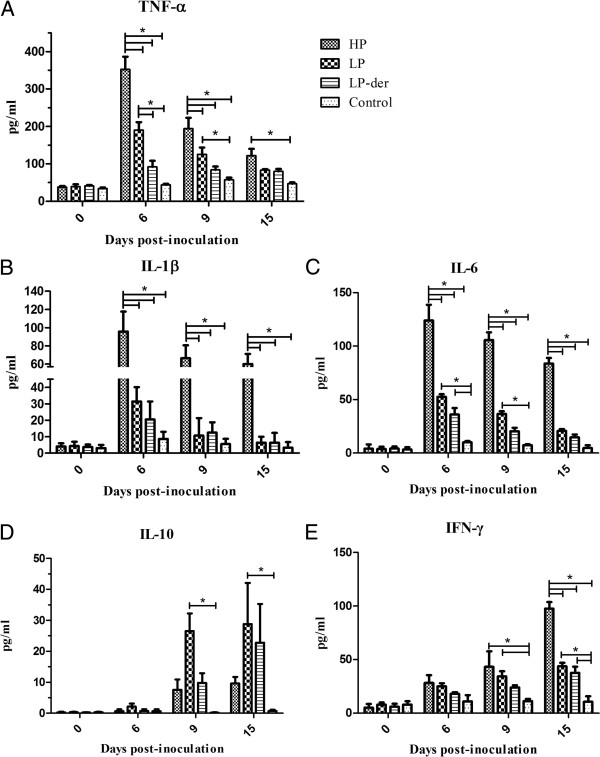
Serum levels of porcine TNF-α (A), IL-1β (B), IL-6 (C), IL-10 (D), and IFN-γ (E) were measured with commercial ELISA kits. Data are represented as mean (± SEM) generated from 6 pigs in all groups at 0 to 15 d.p.i. and 4 pigs in group HP at 9 to 15 d.p.i. (*) indicates a significant difference (p < 0.05) between groups.